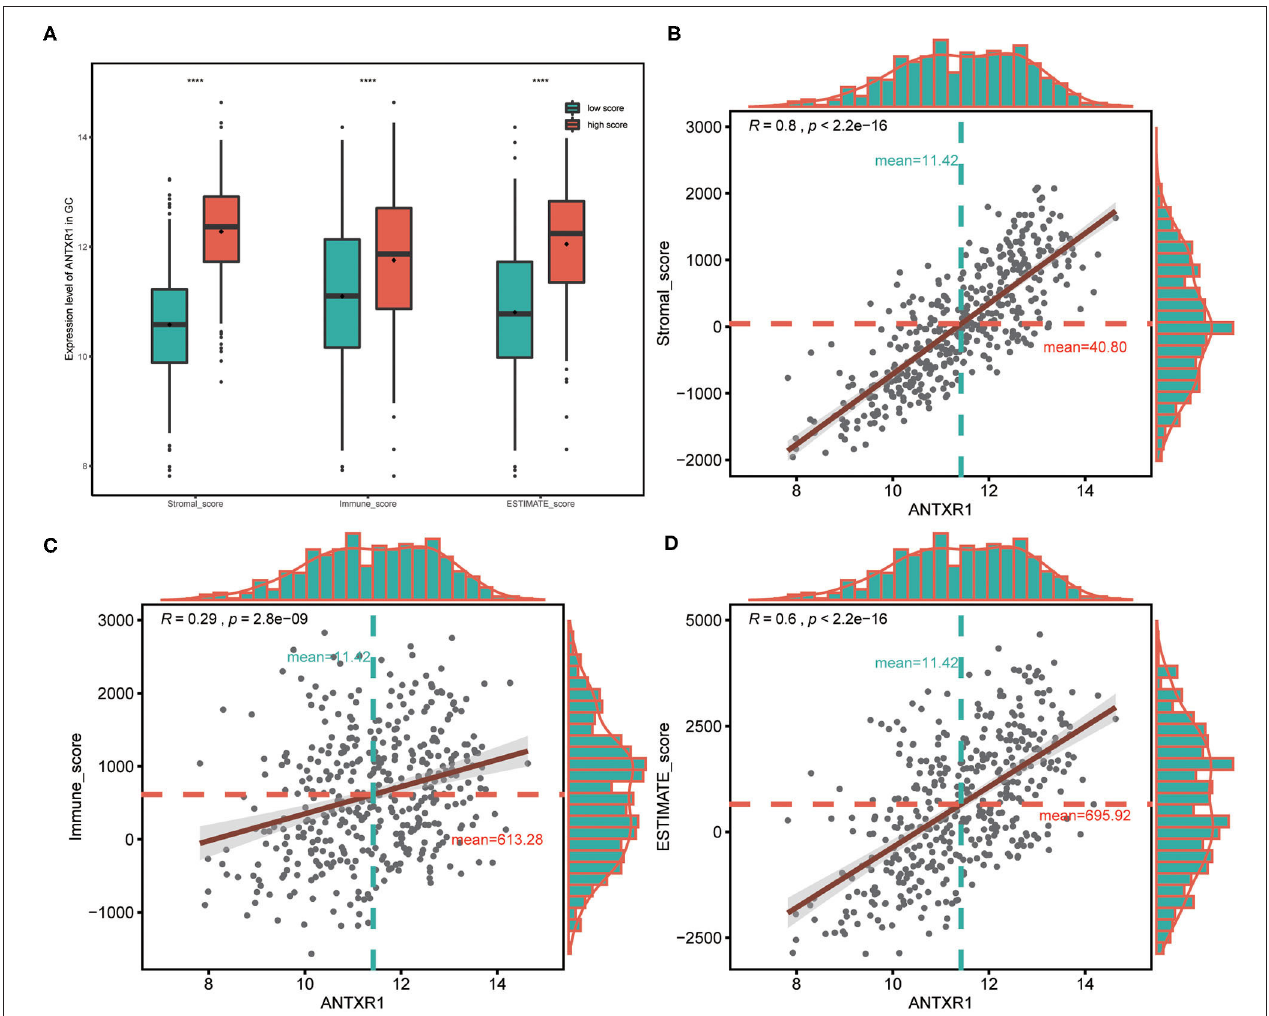
FIGURE 4 | Association between ANTXR1 expression and ESTIMATE score in gastric cancer. (A) High ANTXR1 expression associated with high immune score, stromal score, and ESTIMATE score in gastric cancer patients. Box plot elements (center line, median; box boundaries, upper and lower quartiles; whiskers, maximum and minimum). ANTXR1 expression was positively correlated with stromal score (B) , immune score (C) , and ESTIMATE score (D) in gastric cancer patients. **** P <